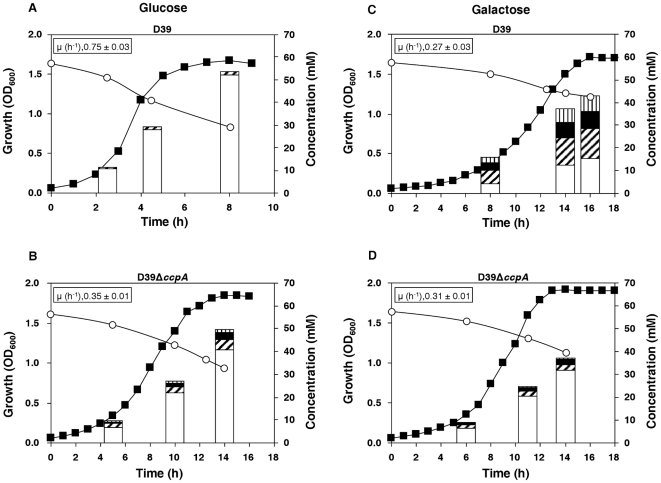
Fermentation profiles of D39 and D39ΔccpA on Glc and Gal.Growth curves, substrate consumption and end-products formed by the D39 (A and C) and D39ΔccpA (B and D) strains growing on Glc (A and B) or Gal (C and D). Culture supernatant samples for substrate and end product analysis by HPLC and/or 1H-NMR were harvested for each of the conditions in the mid-exponential, transition-to-stationary and growth arrest (maximal biomass) time points of the respective growth curves (bars in the plots). To calculate end-product concentrations, values of at least two independent experiments were averaged and the error was below 7% for major products (>2 mM) and 25% for minor products (<2 mM). Initial concentrations of Glc and Gal were 56±1 mM and 57±1 mM, respectively. Time points in substrate consumption curves are averages of at least two independent experiments and the error is below 5%. Symbols: (○), substrate consumption; (▪), growth curve; white bars, lactate; hatched bars, formate; black bars, acetate; stripped bars, ethanol. Growth curves as in Fig. S1, except that OD600 scale (y-axis) is decimal.